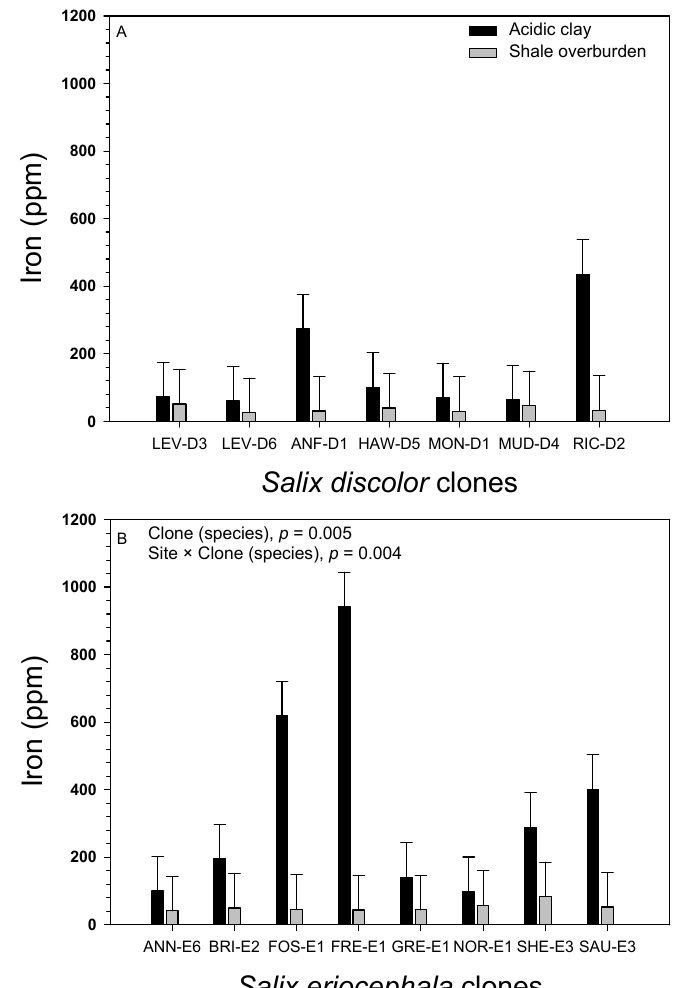
Figure 6. Foliar iron concentrations (mean ± SE) from 15 genotypes of ( a ) Salix discolor (seven) and ( b ) S. eriocephala (eight) on acidic clay and shale overburden sites.